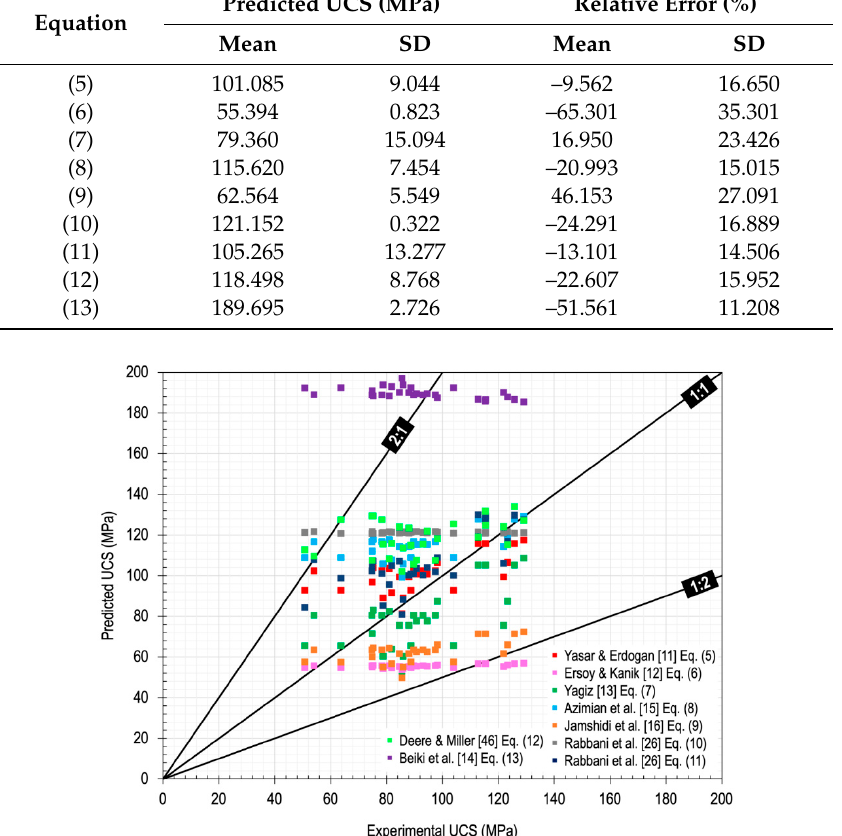
Figure 2. Predicted vs. Experimental UCS values. Figure 2 . Predicted vs. Experimental UCS values. Table 3. Average obtained UCS values in strength tests and average predicted UCS values, as well as their relative errors according to different authors.